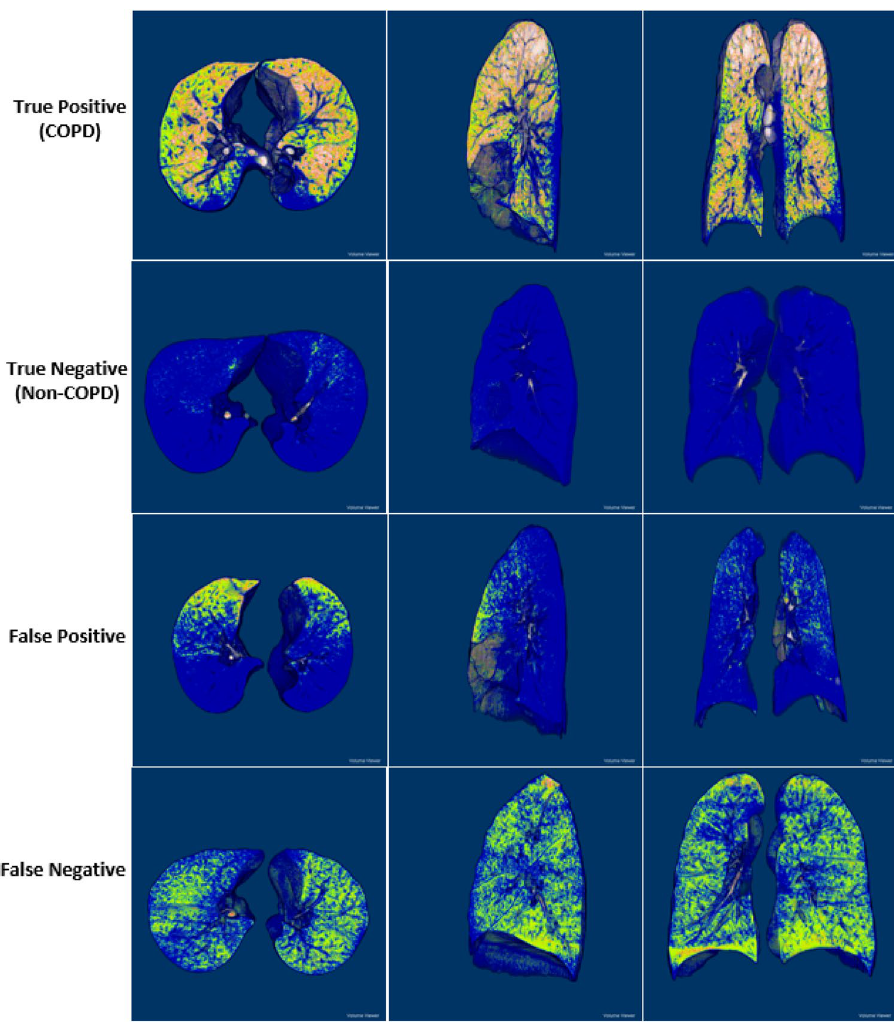
Figure 6. Classification samples of TP (first row), TN (second row), FP (third row), and FN (fourth row) in the axial (left), sagittal (center), and coronal (right) views of 3D PRM images. This figure was generated with ImageJ (version 1.53a, https ://image j.net/) and Microsoft PowerPoint 2010 (version 13328.20292; https ://www.micro